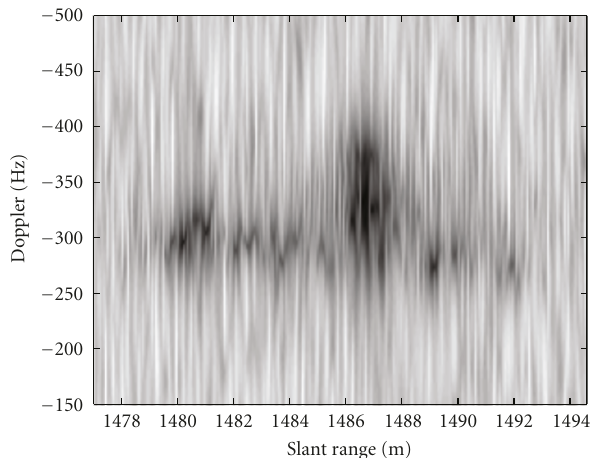
Figure 14: ISAR image obtained by applying the Capon spectral estimator to the real data.